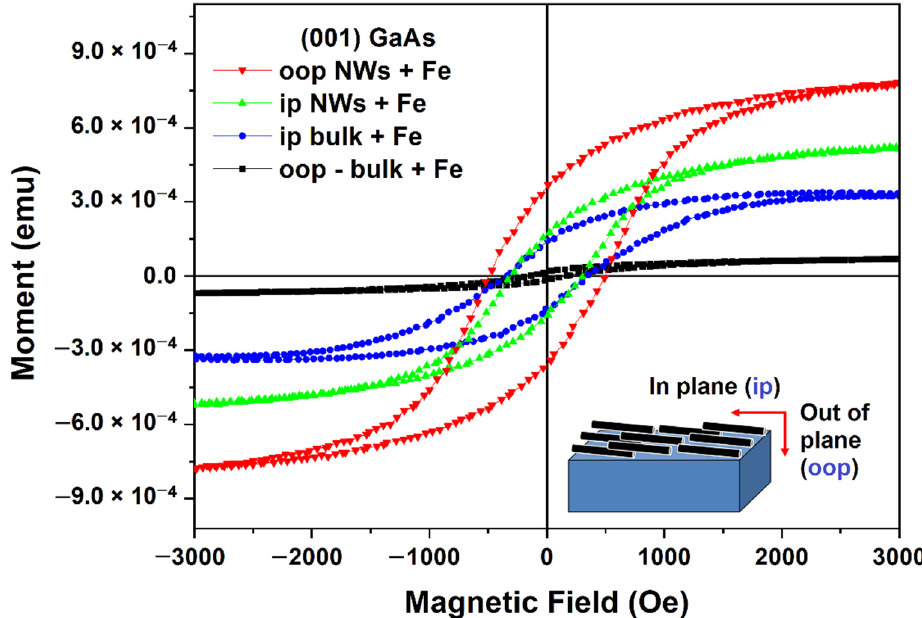
Figure 7. Hysteresis loops measured in in-plane and out-of-plane configurations on nanowires array prepared on (001) GaAs wafers compared with those measured on the substrate covered by a polycrystalline Fe film.